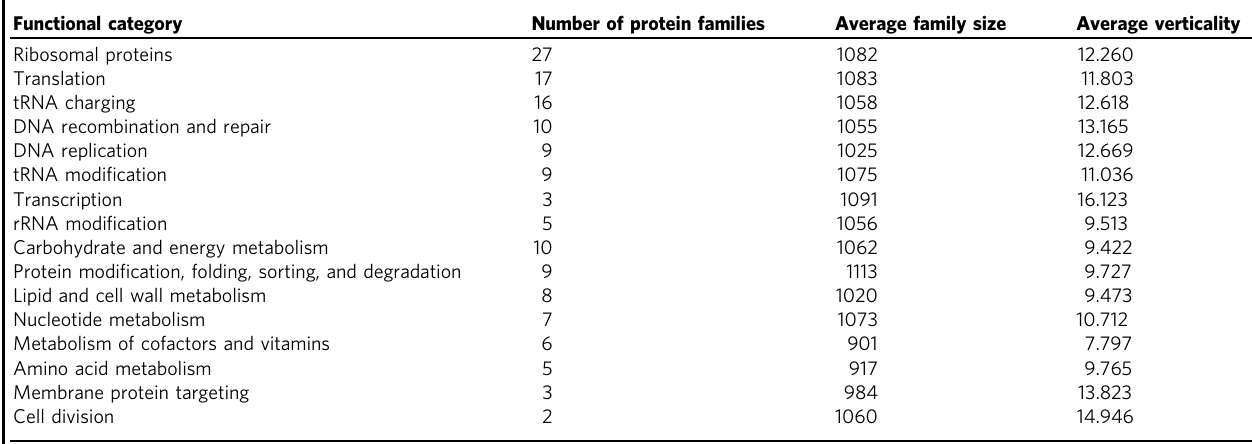
Table 1 Functional categories for the 146 LBCA protein